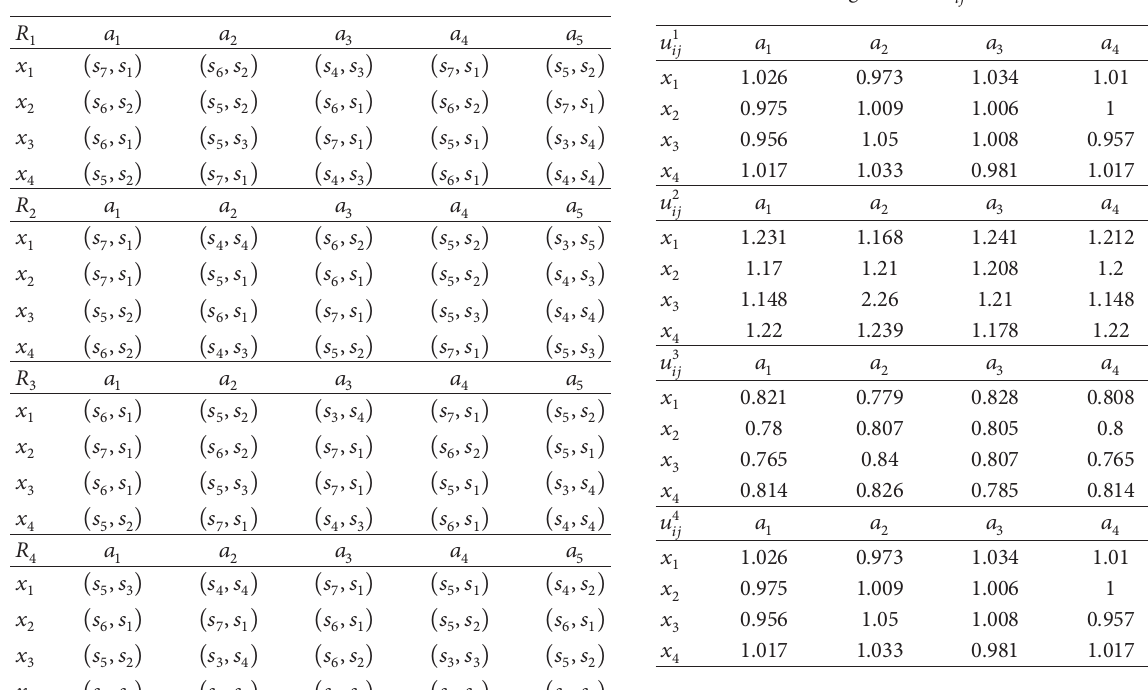
Table 1: Decision matrix 𝑅 𝑖 (𝑖 = 1,2,3,4) .